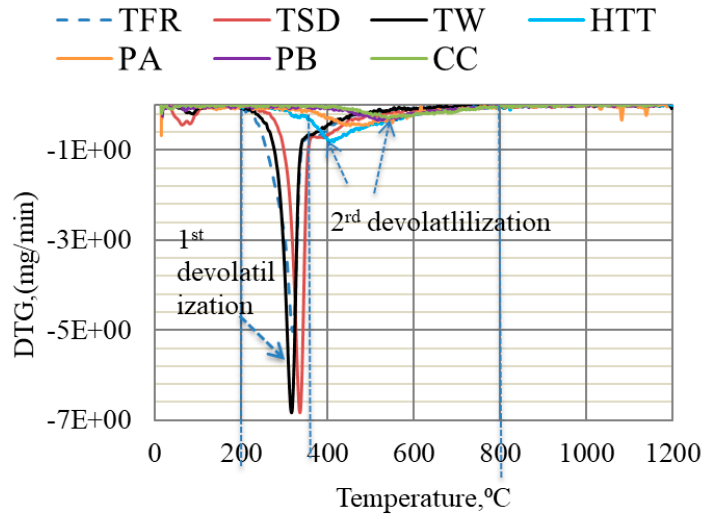
Figure 2. DTG of bio-coals conducted in Ar gas at a heating rate of 5 °C/min up to 1200 °C.